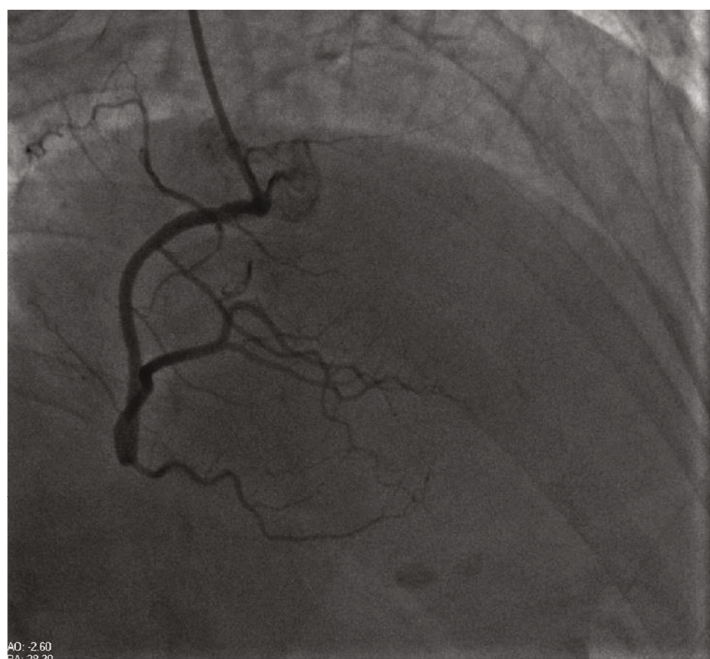
Figure 3: Coronary angiogram showing a view of the right coronary artery.